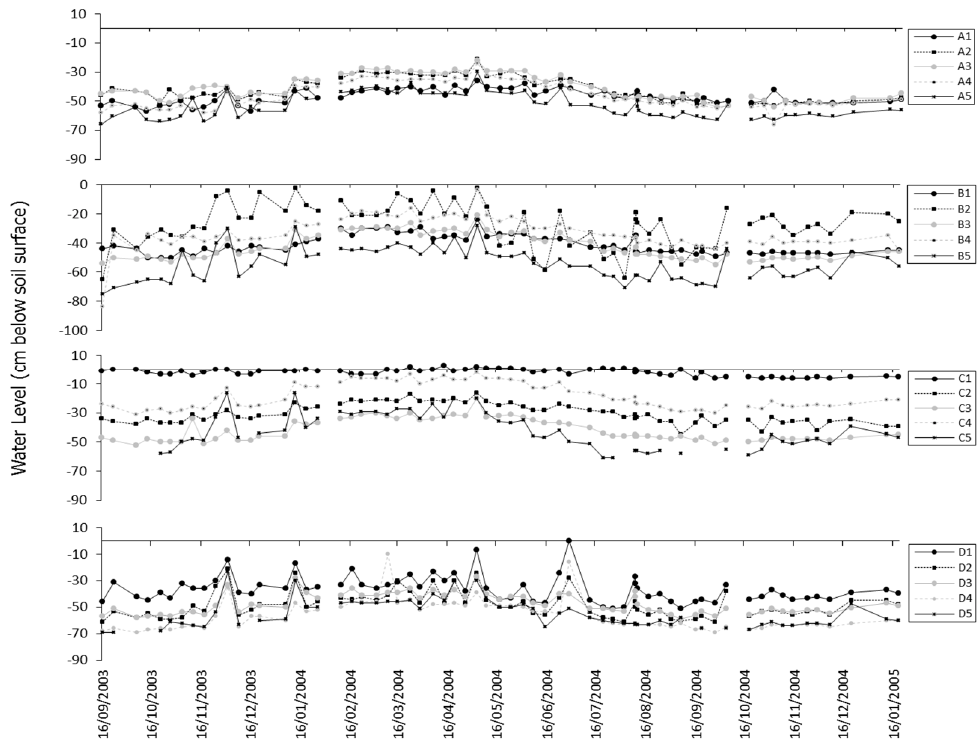
Figure 5. Level fluctuations across the Boxford wetland relative to soil surface (cm). Sampler nest locations are shown in Figure 2.